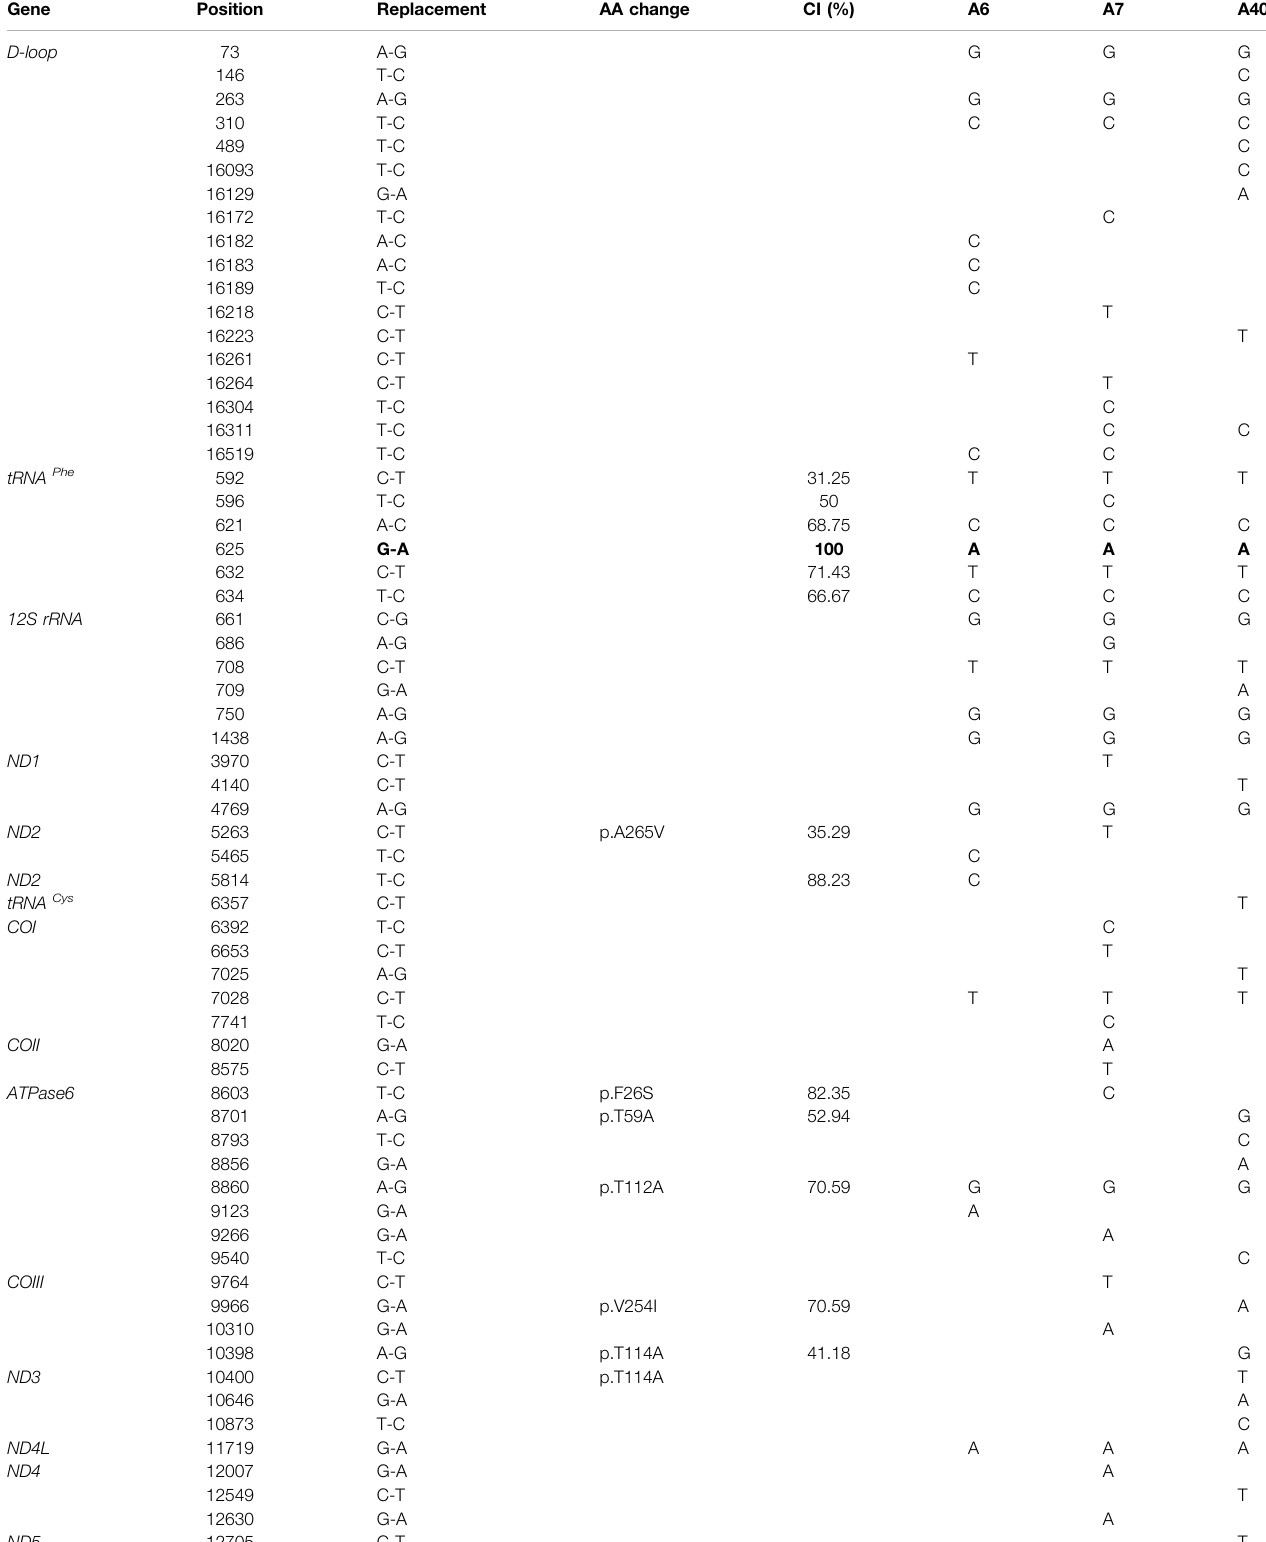
TABLE 2 | mtDNA variants in three Chinese pedigrees with cholecystolithiasis. Gene